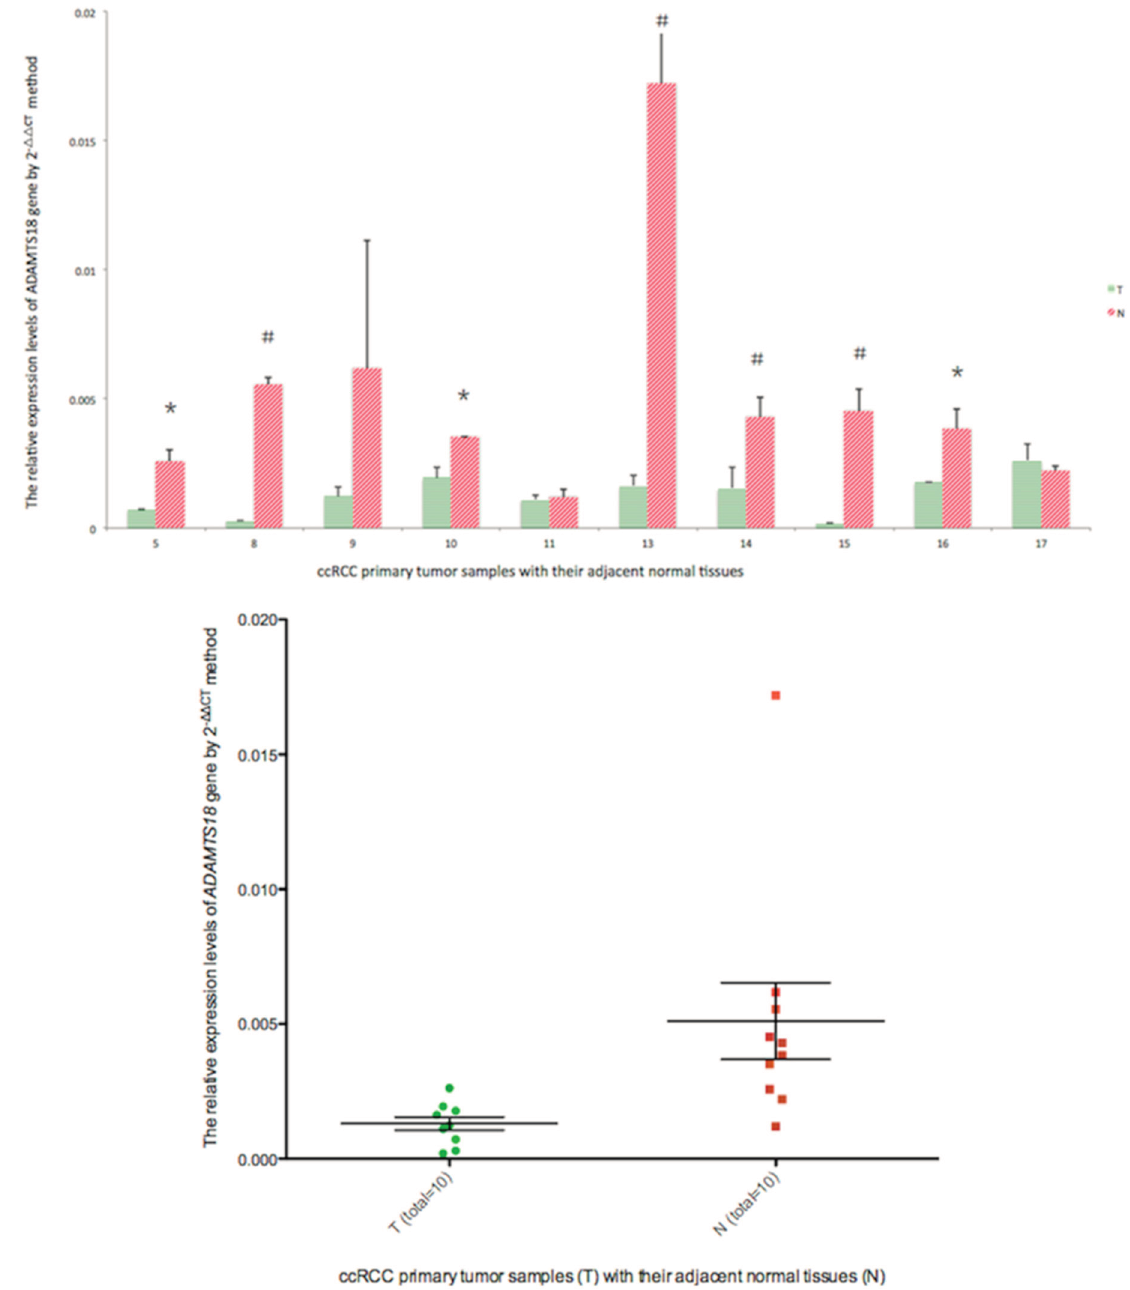
Figure 5. Real-time PCR results illustrating relative mRNA expression levels of ADAMTS18 in 10 pairs of ccRCC primary tumor samples (green dots) compared with their adjacent normal tissues (red dots). * p < 0.05 and # p <